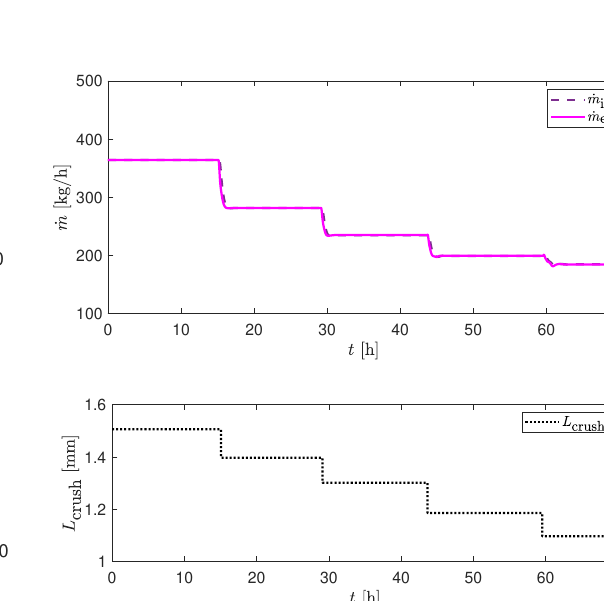
Figure 7: Total mass flow rates of the influent/effluent as a response to the step-by-step change of the crusher gap ( L crush = 1 . 5 → 1 . 4 → 1 . 3 → 1 . 2 → 1 . 1 mm).